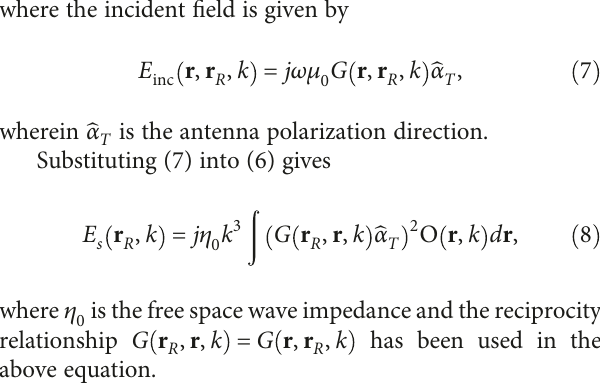
=3. (f) Imaging result using b